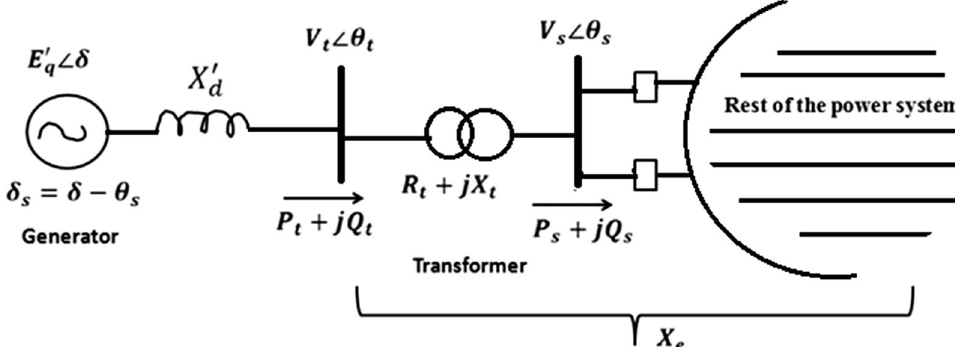
Fig. 1 One line diagram of the MSMIB